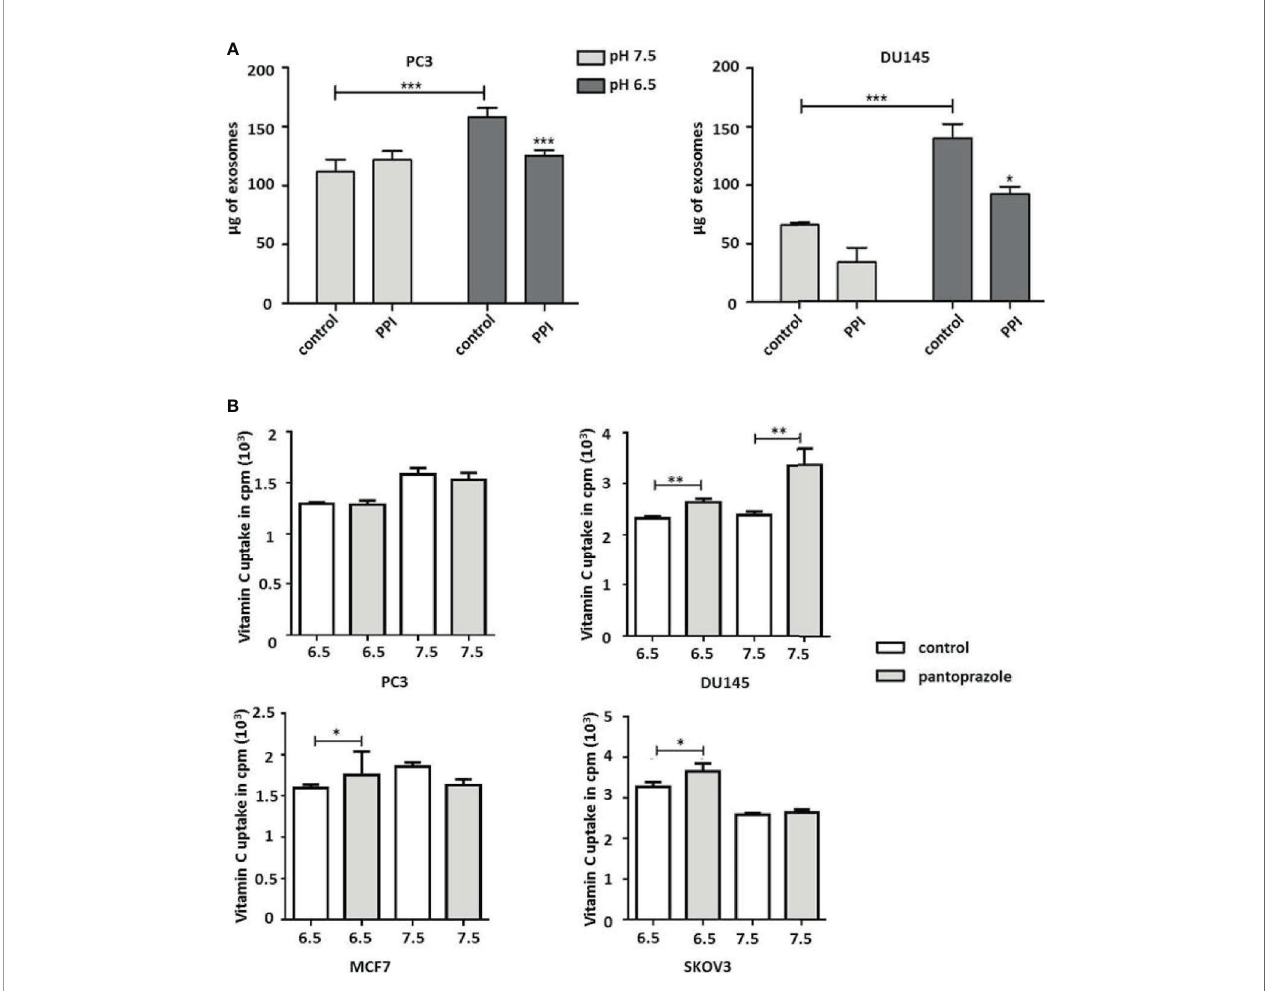
FIGURE 4 | Pantoprazole signi fi cantly increases cellular vitamin C uptake and inhibits the production of exosomes depending on the pH value of the cell culture medium. (A) PC3 and DU145 cells were cultured in cell culture medium with a pH of 7.5 or a pH of 6.5 and treated with pantoprazole (100 m M) (PPI) or left untreated (control). The protein concentration was determined by the BCA protein assay, and exosomes were lysed using RIPA buffer. (B) Vitamin C uptake in prostate (PC3 and DU145), breast (MCF7) and ovarian cancer cells (SKOV3) following treatment with 100 m M pantoprazole for 6 h (grey columns) or without pantoprazole (control, white columns) in cell culture medium with a pH of 6.5 or 7.5. The bars represent the mean and SD of the mean of n ≥ 3. *p < 0.05; **p < 0.01, ***p <